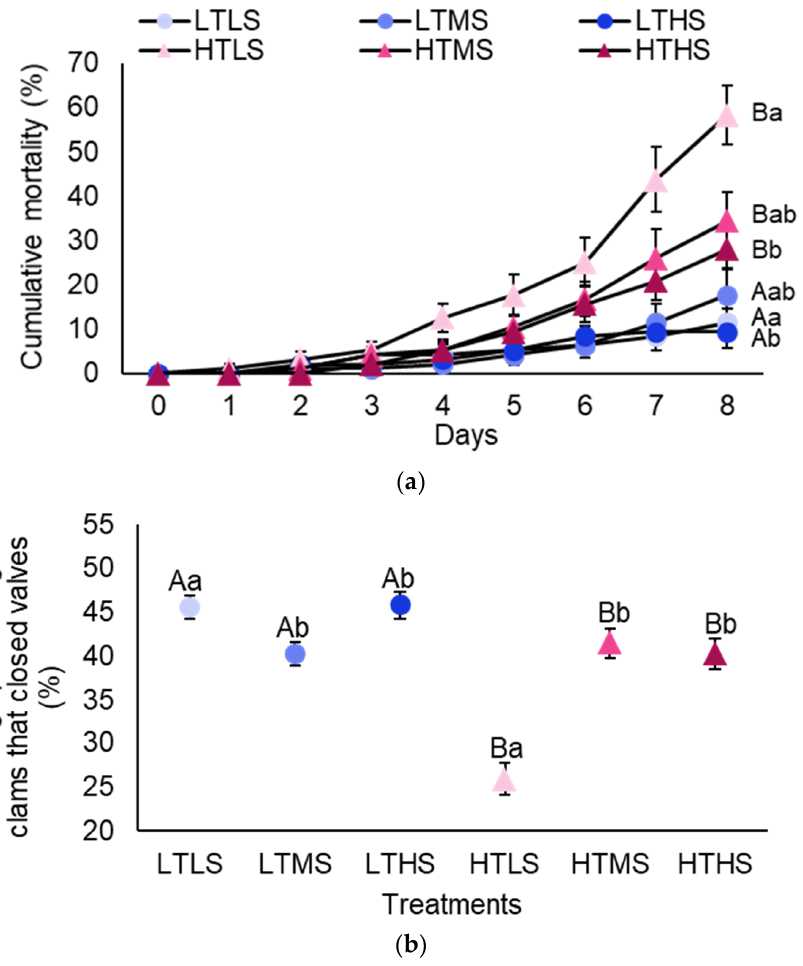
Figure 5. ( a ) Cumulative mortality rate (mean ± SE) and ( b ) the average proportion of valve closure (mean ± SE) of Venerupis philippinarum during exposure to two different temperatures (21 °C and 24 °C) and three different salinities (18, 21, and 24 psu) for eight days. Different uppercase letters indicate significant differences between treatments for temperature, and different. Abbreviation: LTLS, low temperature and low salinity; LTMS, low temperature and middle salinity; LTHS, low temperature and high salinity; HTLS, high temperature and low salinity; HTMS, high temperature and middle salinity; HTMS, high temperature and high salinity. Table 1. Results of the two-way repeated-measures ANOVA for the effects of temperature and sa- linity on the valve closure of Venerupis philippinarum.